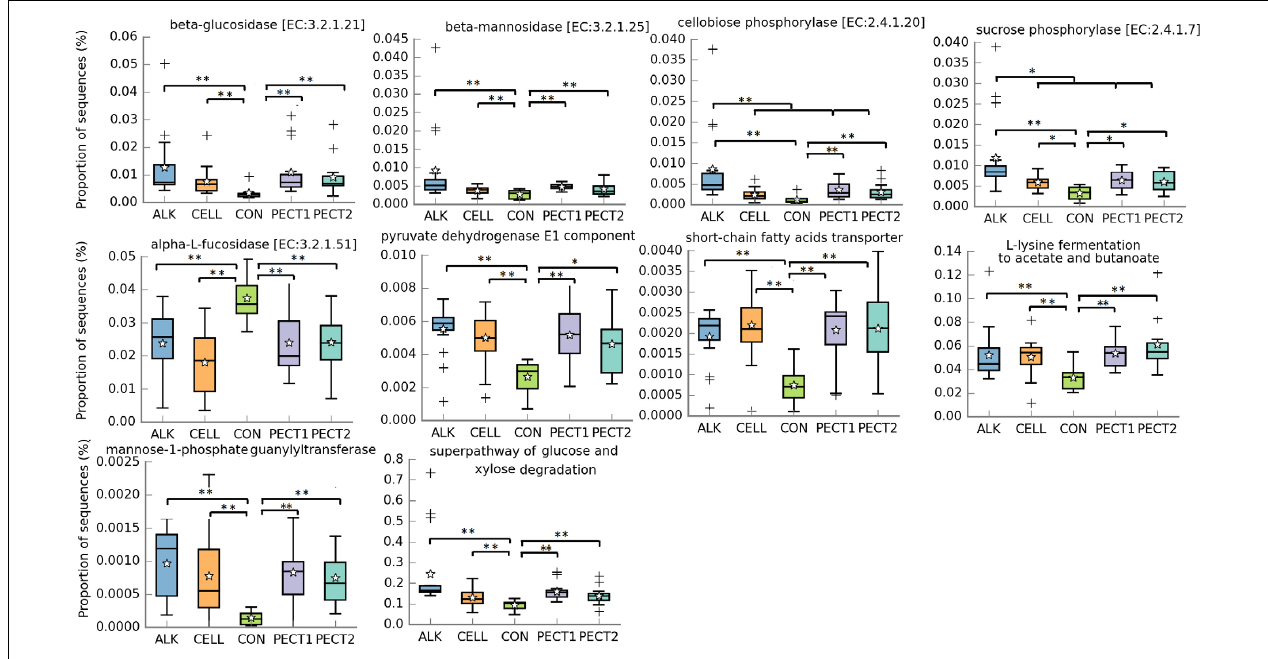
FIGURE 5 | Significantly different metagenomic functions in relative abundance among ALK, CELL, CON, PECT1, and PECT2. The predicted abundances of microbial functional profile in pre-treated RSM compared to CON were analyzed by ANCOVA. * P < 0.05; ** P < 0.01. The stars represent the group means while the middle bars of the boxplots represent the median and the plusses represent outliers.